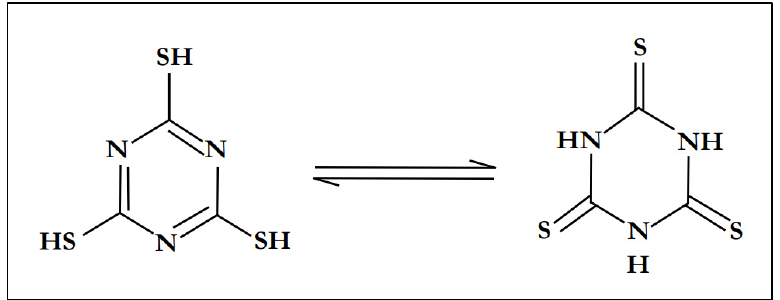
Figure 1. Tautomeric structures of trithiocyanuric acid.